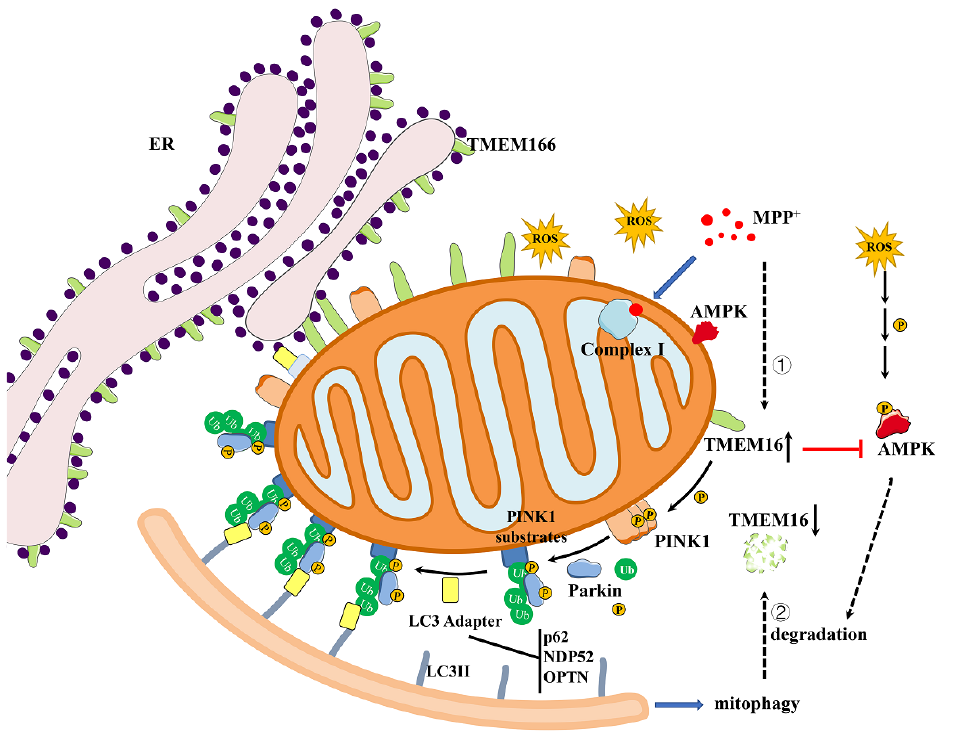
Figure 7. A model of TMEM166 regulation in MPP + -induced oxidative stress. TMEM166 mainly localizes in ER and partially in mitochondria. MPP + binds to mitochondrial complex I and blocks the electron transfer of oxidative phosphorylation, leading to the production of ROS, which could eventually activate AMPK to promote cell survival. MPP + -induced cell oxidative stress could be divided into two stages. 1 (cid:13) The first is the stage in which the generated ROS starts to damage the mitochondria and mitochondrial energy production decreases slightly. At this time, TMEM166 is up-regulated to promote mitophagy dependent on PINK1/Parkin to clear damaged mitochondria to maintain cell homeostasis. 2 (cid:13) The second is that ROS has been generated enormously and the reduction in mitochondrial energy production has threatened cell survival. At this time, excessive TMEM166 in mitochondria will inhibit AMPK activation, causing mitochondrial dysfunction and oxidative stress aggravation. In this stage, more and more damaged mitochondria are produced and need to be cleared by mitophagy. The expression of TMEM166 is actually very high, but the rate of mitophagic/autophagic degradation exceeds the rate of its synthesis, causing its protein level to drop and AMPK activation to increase, which could promote mitochondrial biogenesis and produce more ATP, to maintain cell survival. In addition, activated AMPK promotes TMEM166 degradation, possibly through an AMPK-dependent autophagy/mitophagy